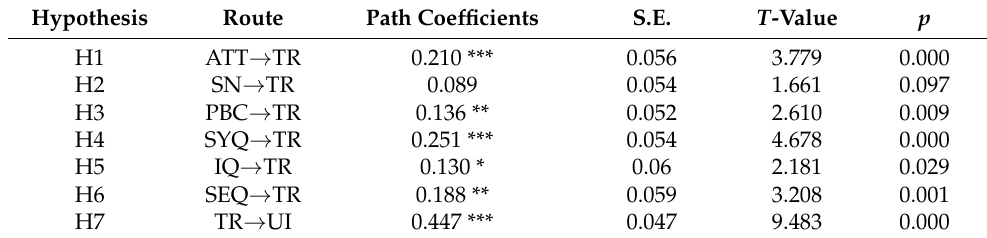
Table 4. Results of hypotheses